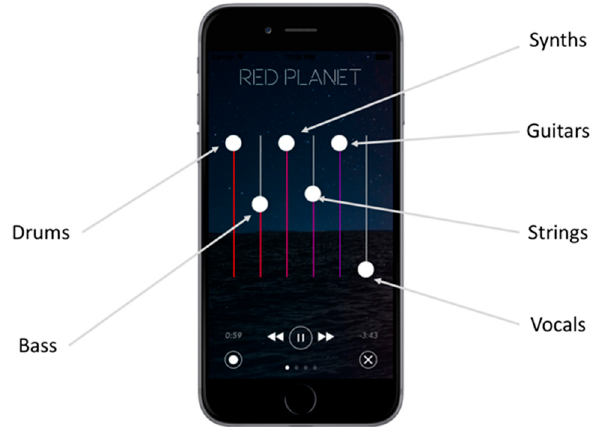
Figure 5. Instrument stem faders within the variPlay app. Faders allow mixing, muting, and soloing of musical components.